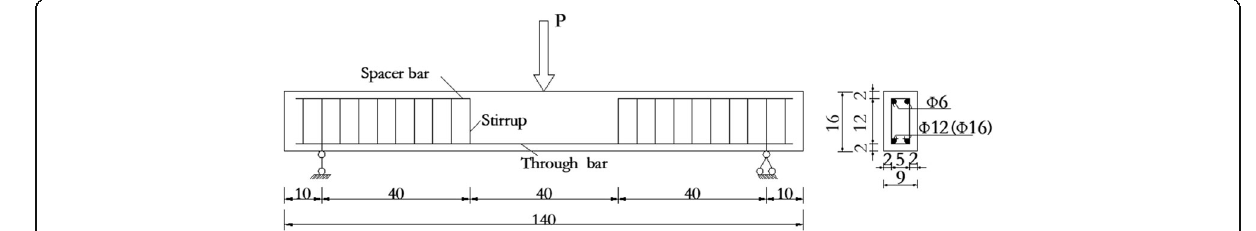
Fig. 5 Dimensions of test specimen and loading